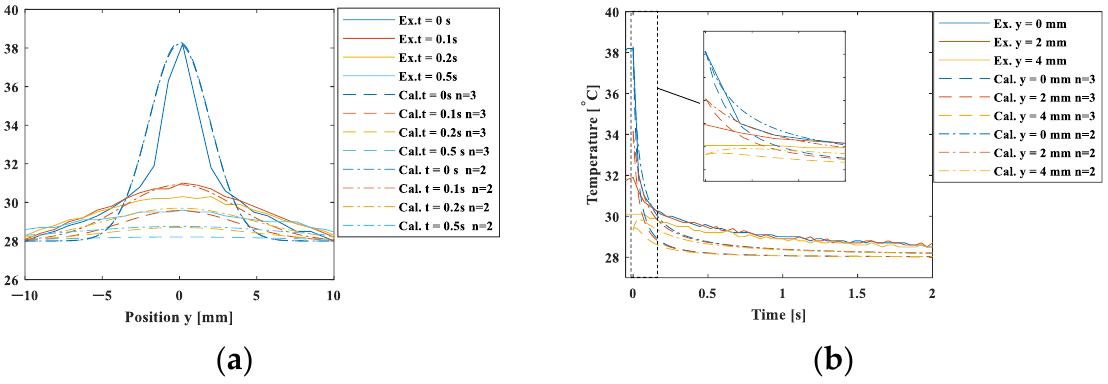
Figure 9. Comparison of the cooling process in the experiment and the point heat source model. ( a ) spatial changes; ( b ) temporal